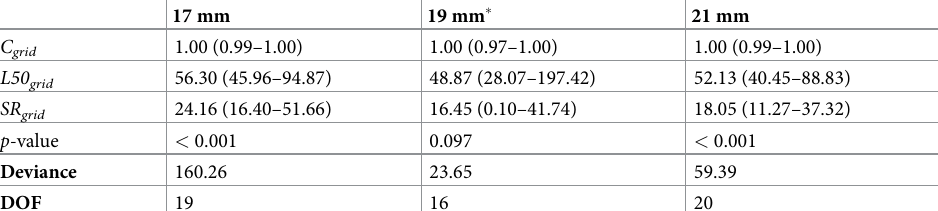
Table 2. Selectivity parameters and fit statistics for Northern shrimp describing the grid passage probability for the three different grids considered in this